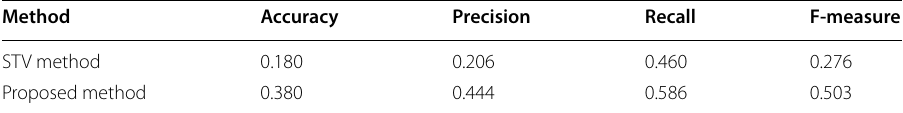
Table 5 Results on Wiki-1 with GraphWave